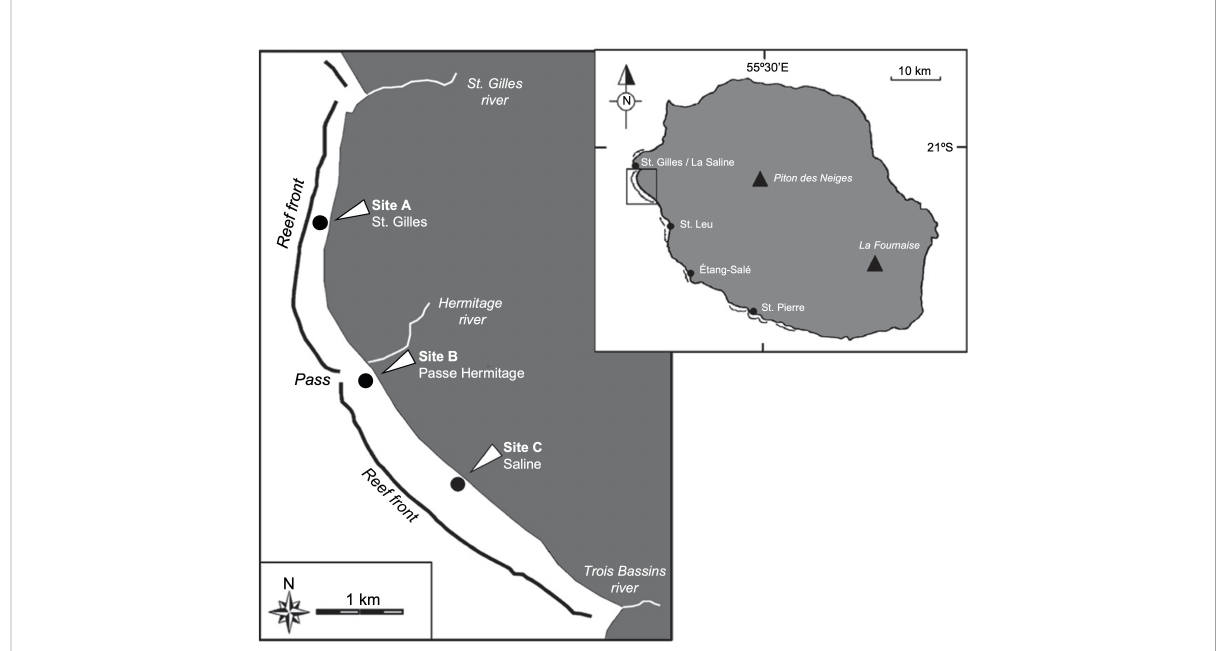
FIGURE 1 Sampling locations at Reunion Island. “ Saint-Gilles ” (STG, site A), “ Passe Ermitage ” (PAS, site B) and “ Saline ” (SAL, site C ). Modi fi ed from Clavier et al.